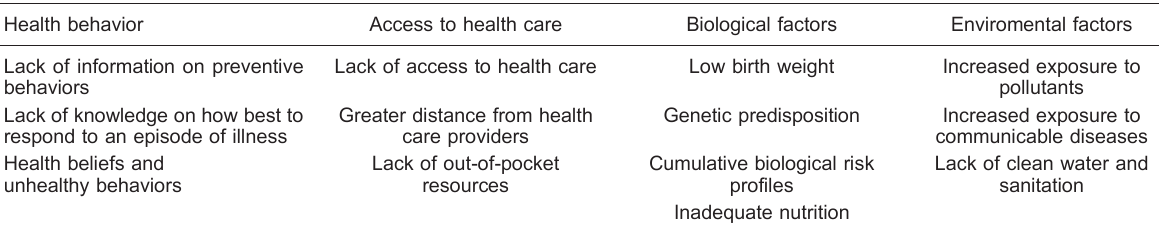
Table 1. Possible mechanisms by which poverty increases the burden of